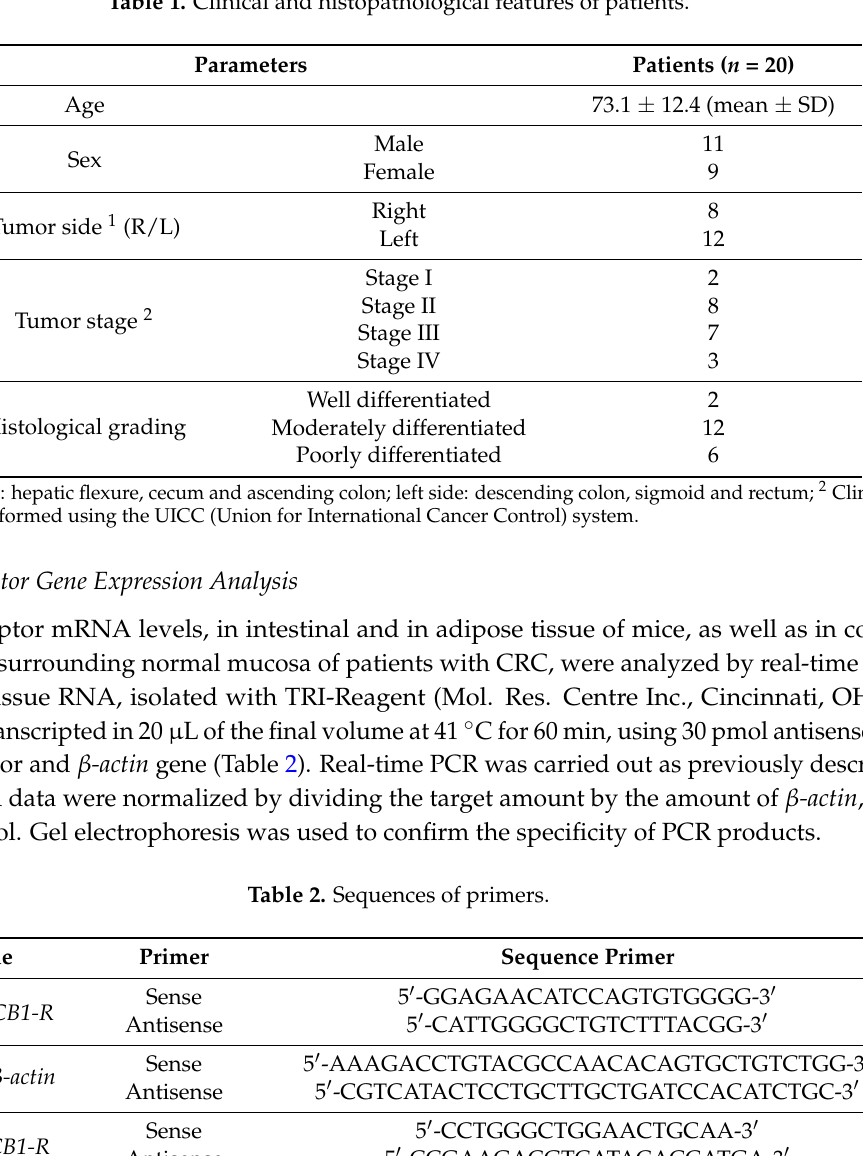
Table 1. Clinical and histopathological features of patients.